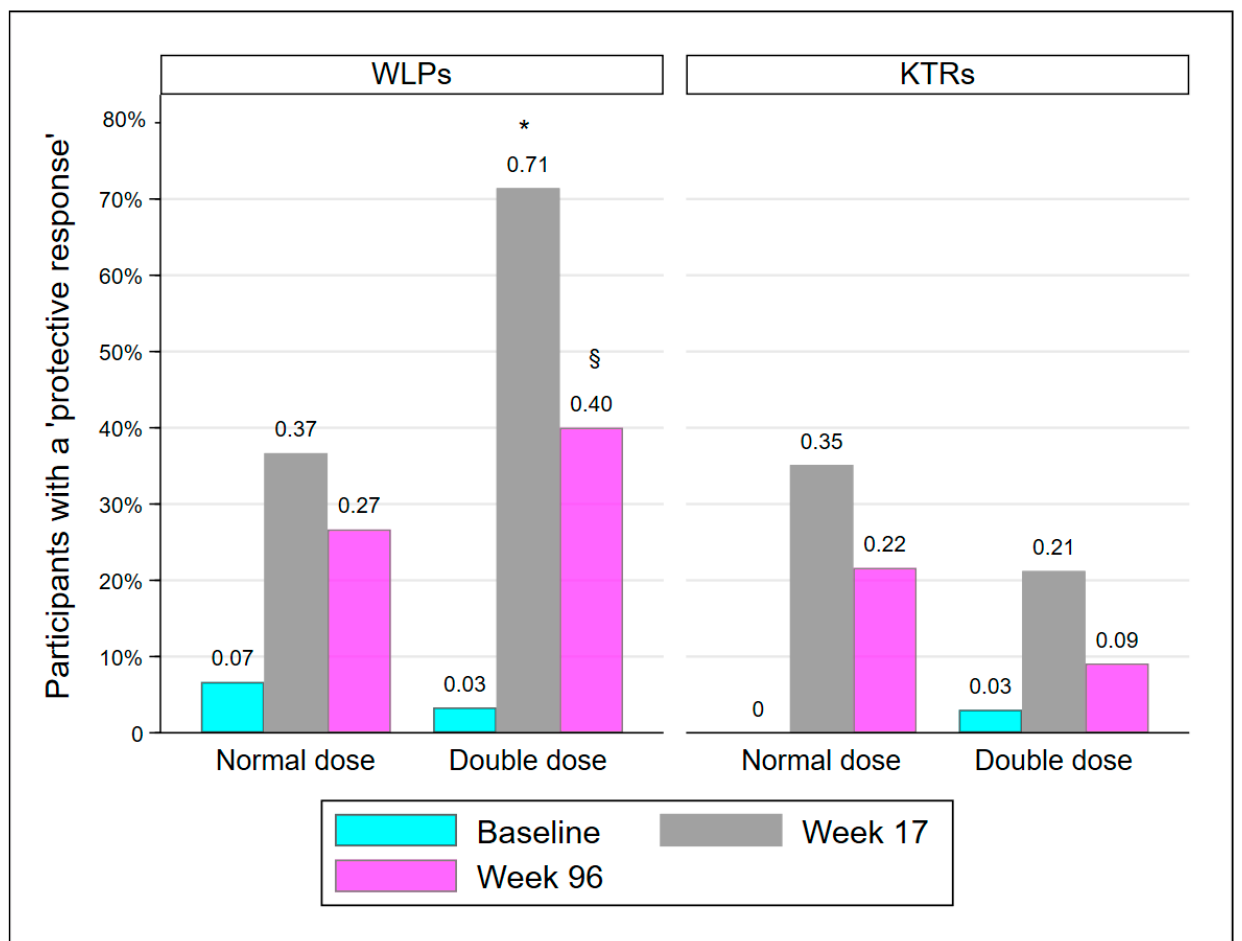
Figure 2. Participants protected at baseline, week 17, and week 96. Abbreviations: WLP, patients on the kidney transplant waiting list; KTR, kidney transplant recipient. *: p < 0.01, compared to WLP-ND week 17, §: p < 0.05, compared to week 17 within group.